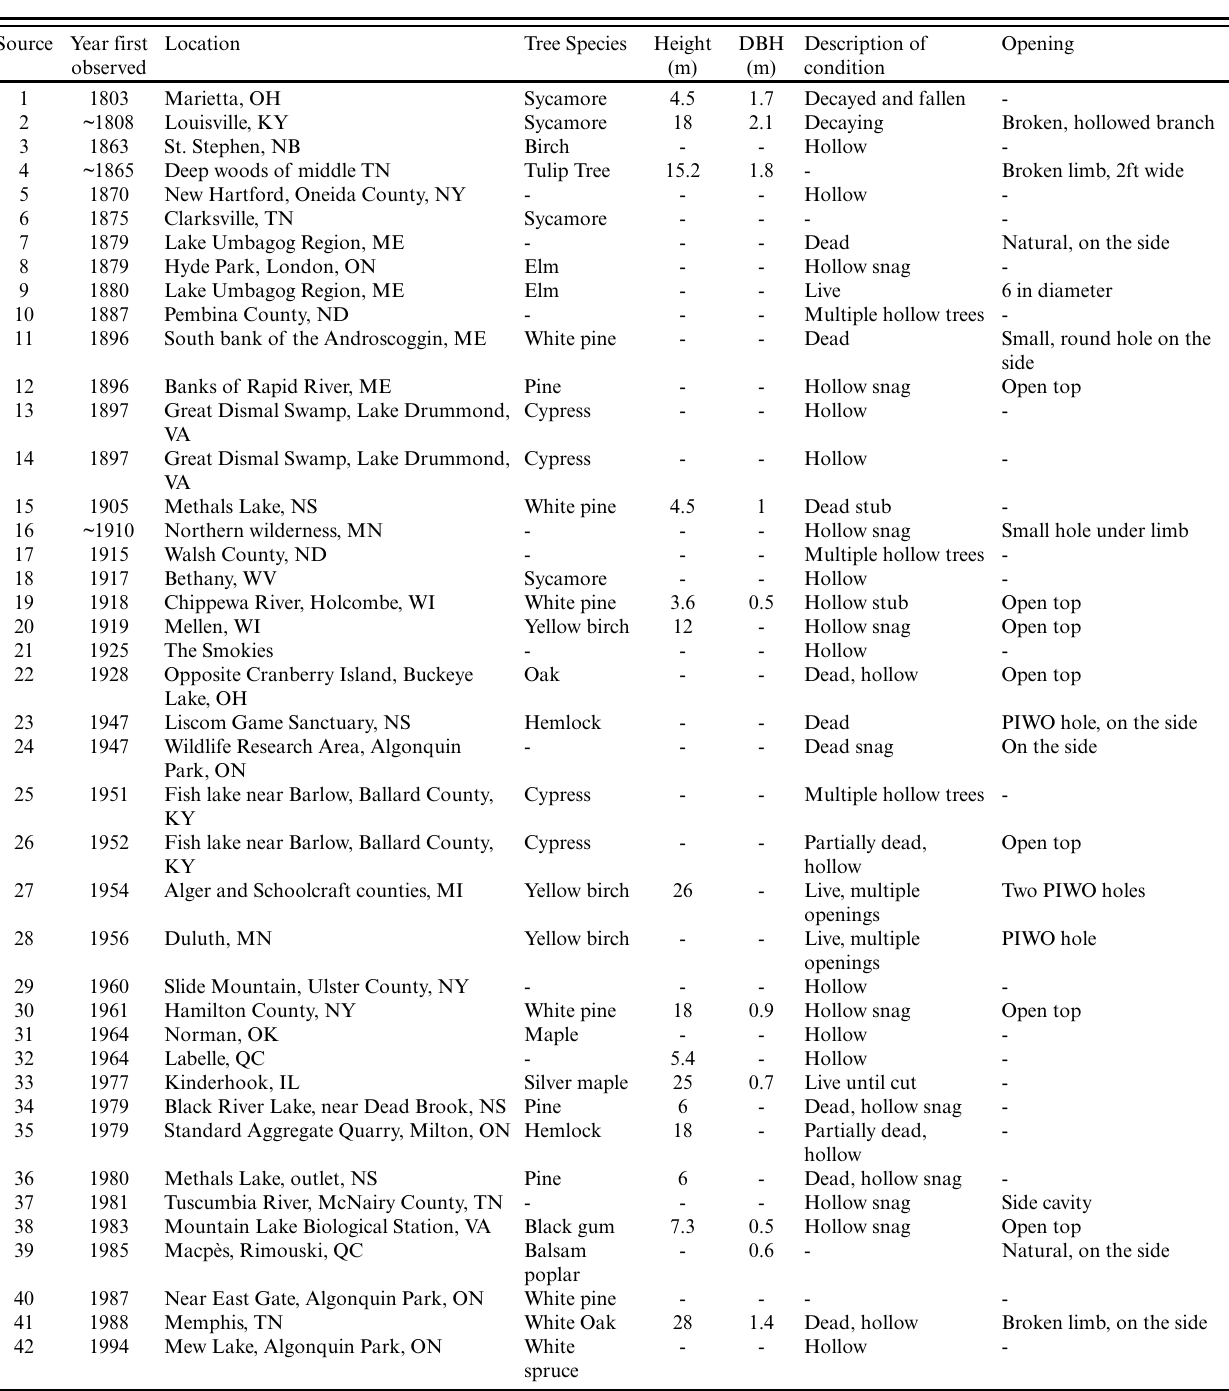
Table 1 . Reports of Chimney Swift nest and roost trees in North America. Sycamore = Platanus spp.; Tulip tree = Leriodendron tulipifera ; White pine = Pinus strobus ; Yellow birch = Betula alleghaniensis ; Silver maple = Acer saccharinum ; Black gum = Nyssa sylvatica ; Balsam poplar = Populus balsamifera ; White oak = Quercus alba ; White spruce = Picea glauca ; Sugar maple = Acer saccharum ; Red maple = Acer rubrum ; PIWO = Pileated Woodpecker ( Dryocopus pileatus